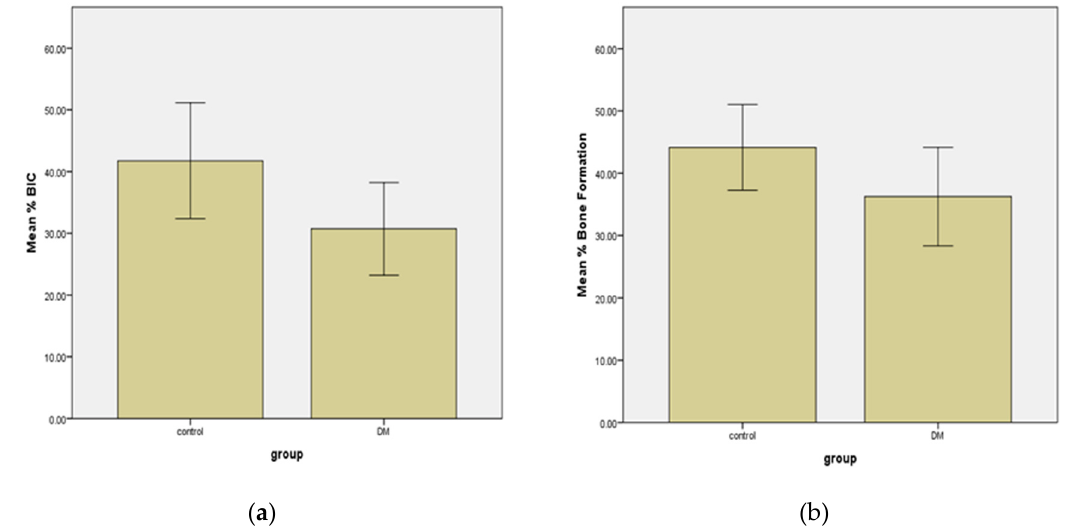
Figure 6. Comparison of %BIC and % bone formation between T2DM and controls. %BIC and % bone formation in T2DM group were significantly lower than their counterpart. (( a) % BIC) (( b) % Bone formation)